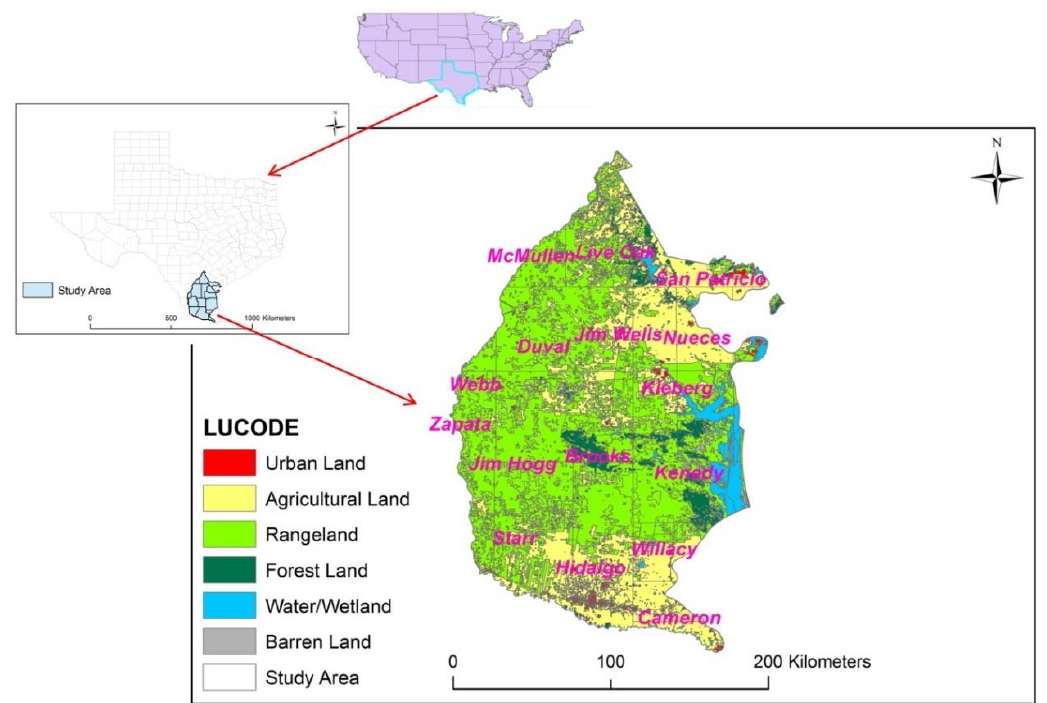
Figure 1. Study area location in Texas and land use/land cover (LULC).